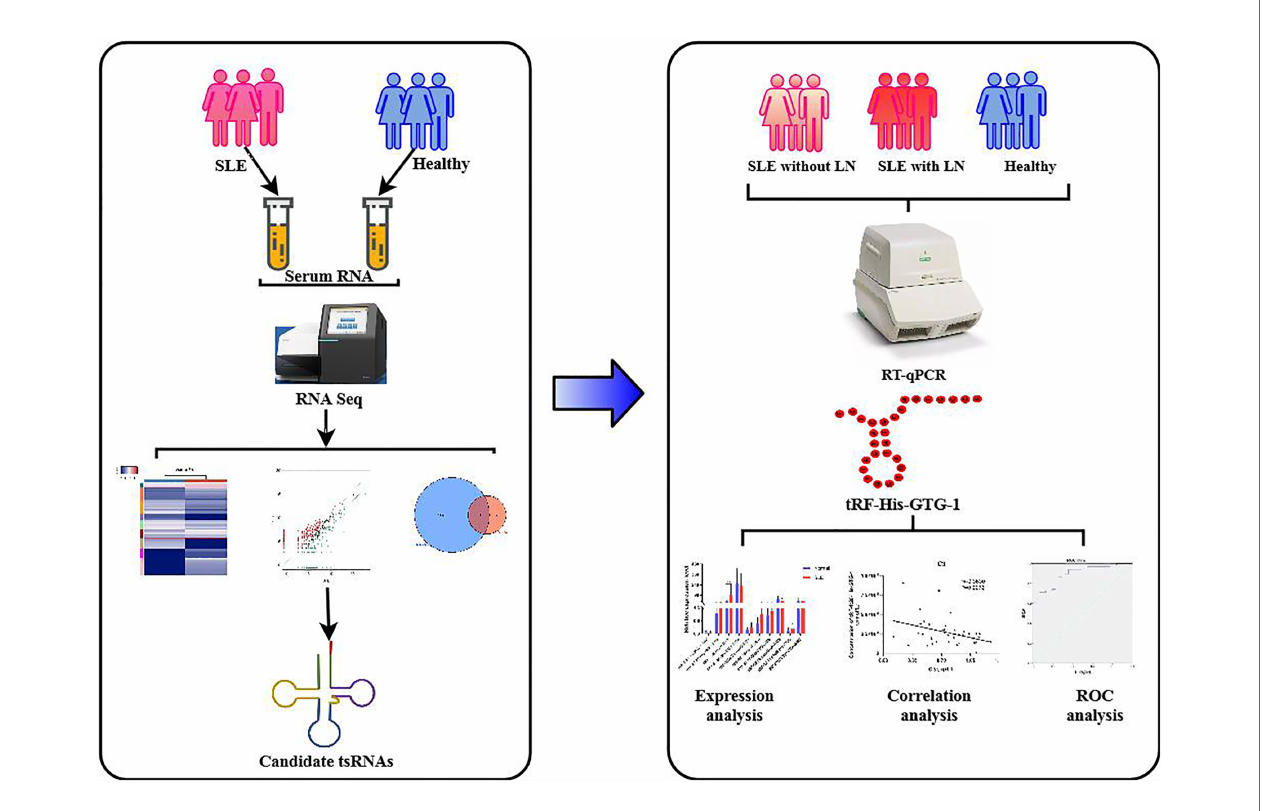
FIGURE 1 | Work fl ow of the